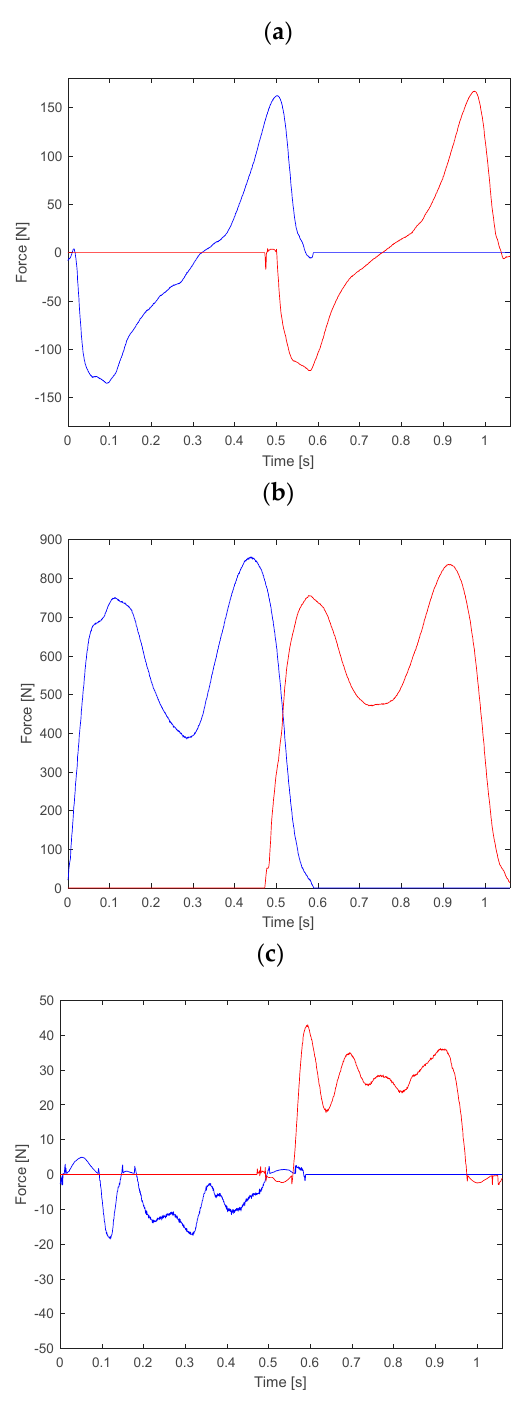
Figure 2. Components of GRF in: ( a ) anterior/posterior—Fx; ( b ) vertical—Fy; ( c ) medial/lateral—Fz direction of the left lower limb (blue line) and of the right one (red line) in sport shoes.